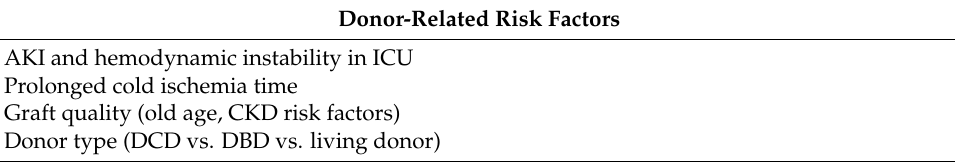
Table 1. The most common causes of